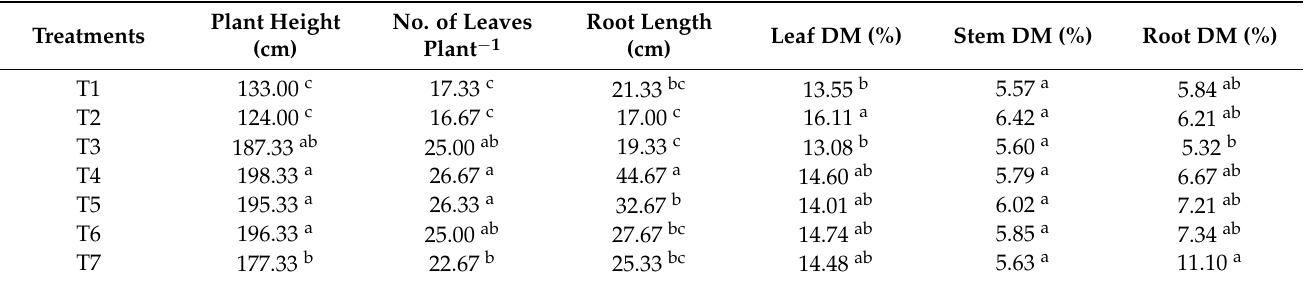
Table 1. Effect of chemical, organic, and biofertilizer treatments on some vegetative growth traits of cucumber plants grown under greenhouse conditions.